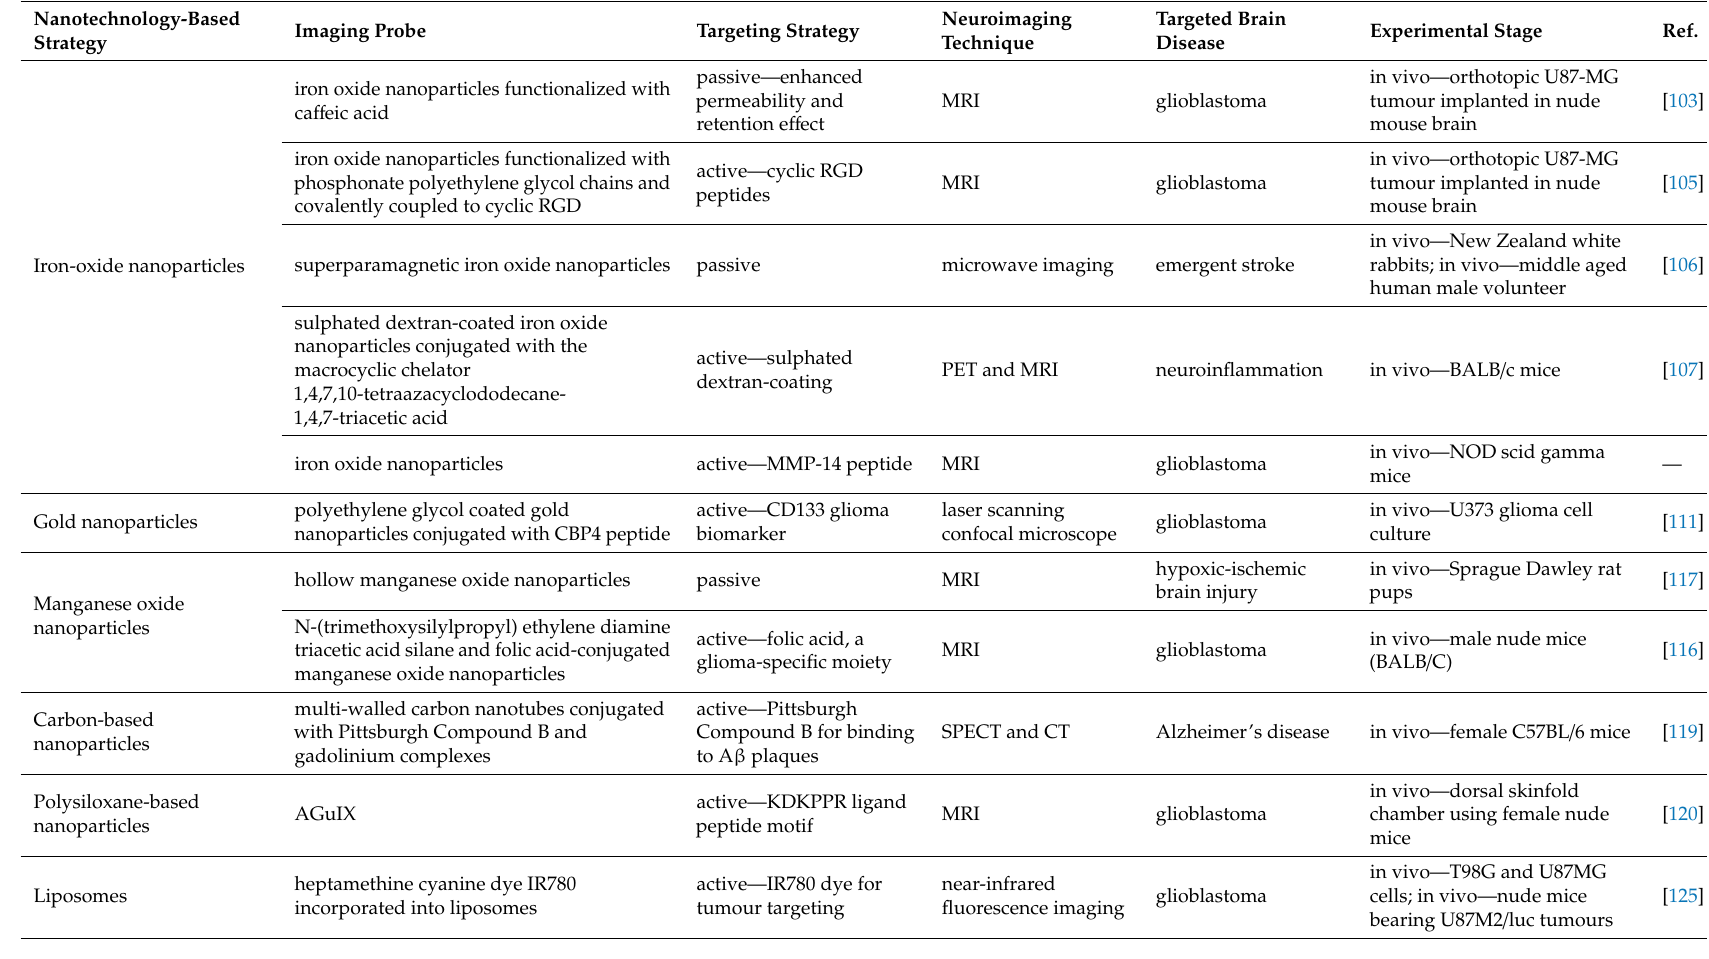
Table 2. A summary of the nanotechnology-based applications for the diagnosis of brain